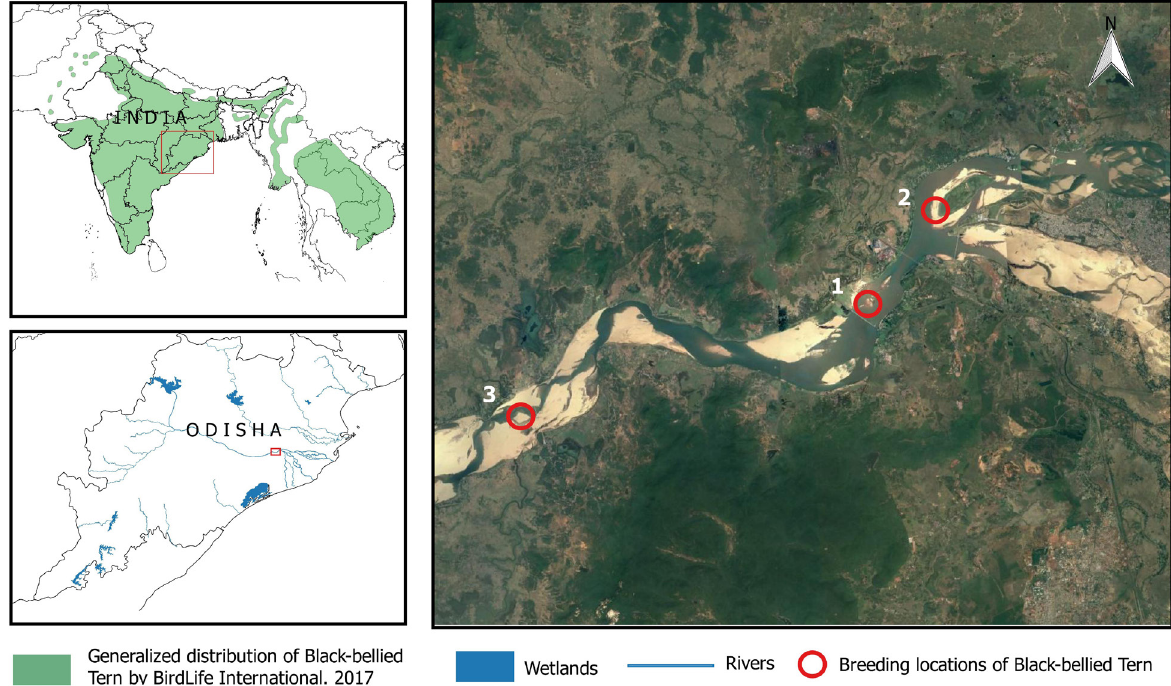
Figure 1. Map showing the distribution and breeding locations of Black-bellied Tern along the Mahanadi River in Odisha, eastern India. 1 - Mundali, 2 - Kakhadi, 3 -